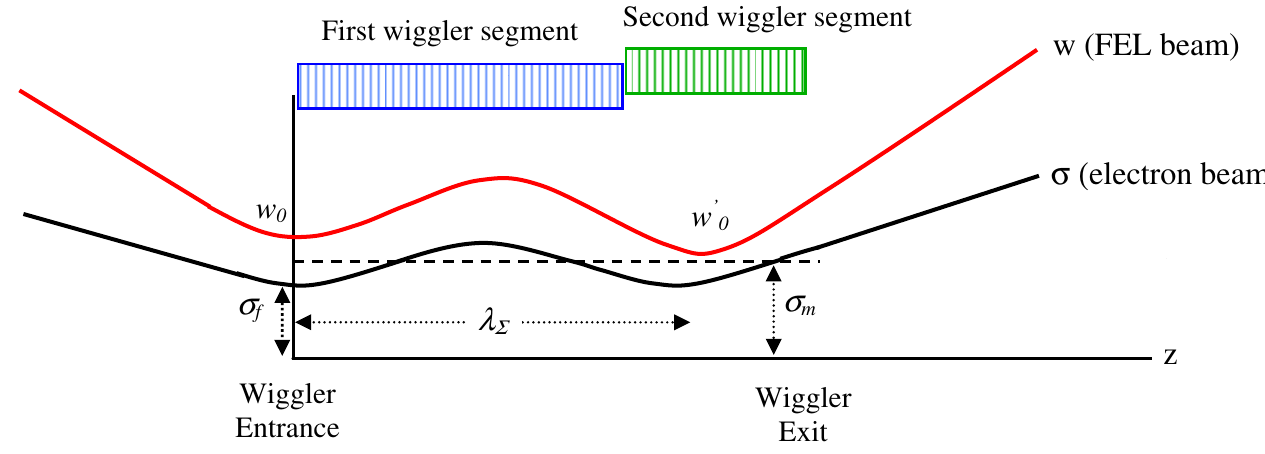
FIG. 1. (Color) Illustration of a scalloped electron beam interaction in a two-stage